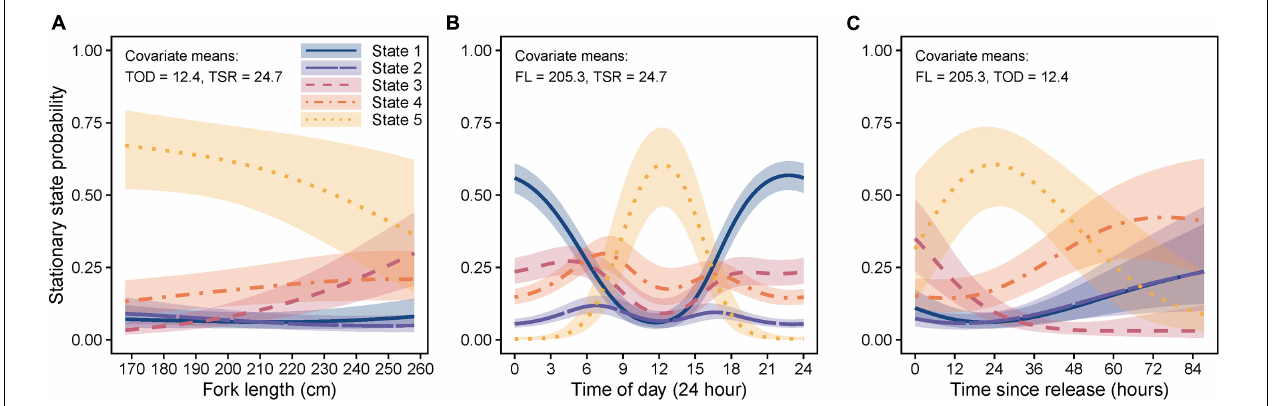
FIGURE 7 | Marginal stationary state probabilities (shading = 95% confidence intervals) for covariates (A) fork length (FL), (B) time of day (TOD), and (C) time since release (TSR), included in the best-fit five-state hidden Markov model. Marginal stationary state probabilities were computed across the range of observed values for each covariate individually while holding all other covariates at their mean values (indicated at the top of each plot). State 1 (navy/solid line) = diving slow/linear, state 2 (purple/long dash line) = diving rapid/tortuous, state 3 (crimson/dashed line) = level linear, state 4 (orange/dot-dash line) = level meandering, and state 5 (gold/dotted line) = level highly tortuous/circular.